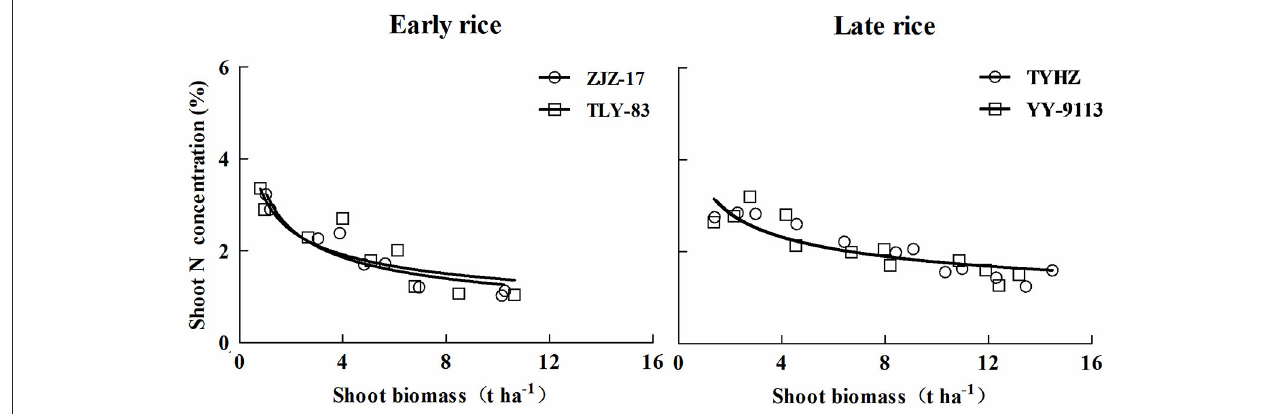
FIGURE 2 | Critical dilution curves of early rice (ZJZ-17, N c = 3.49 W − 0.47 , R 2 = 0.8982 and TLY-83, N c = 3.28 W − 0.42 , R 2 = 0.7661) and late rice varieties (TYHZ, N